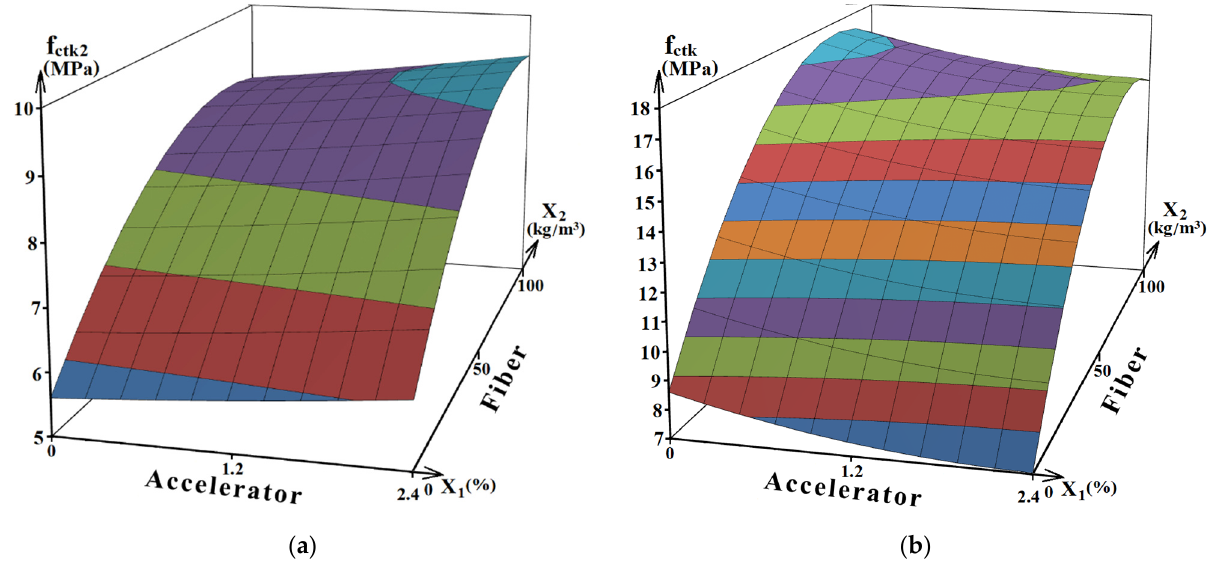
Figure 5. The combined effect of varied composition factors on the flexural strength of concretes and fiber-reinforced concretes at the age of 2 days ( a ) and 28 days ( b ).